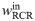
Mixed feedback may enhance both excitatory response to stimuli within the receptive-field center (unlike inhibitory feedback alone), and suppressive effects of stimuli in the surround (unlike excitatory feedback alone).Top row: predicted area-response curves of relay cells for different arrangements of cortical feedback using static spot stimuli. Bottom row: optimal size and suppression index (αs) are shown as a function of cortical feedback weight for different feedback configurations. These are extracted from the size tuning curve using static spot (solid lines, top row) and patch grating (dashed lines, |kg| ≈ 1/deg) as stimulus (bottom left figure). The values on the x-axis represent factors multiplied with the default values for wRCRin and wRCRex listed in Table 1. Default values for fixed parameters are also listed in this table.